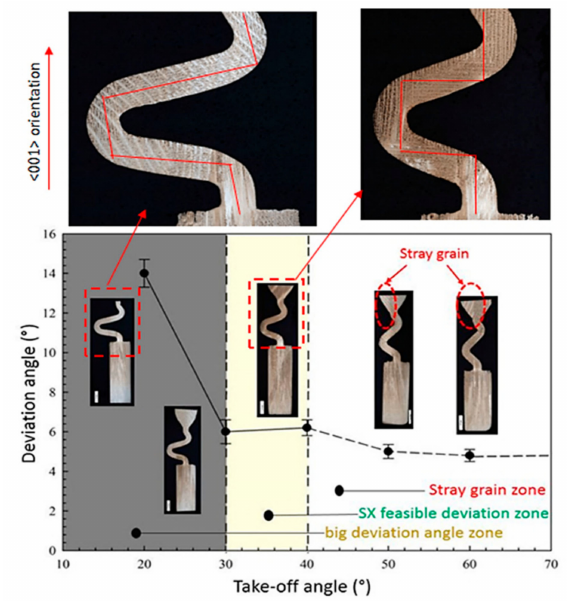
Figure 7. Correlation between deviation angle and take-o ff angle.